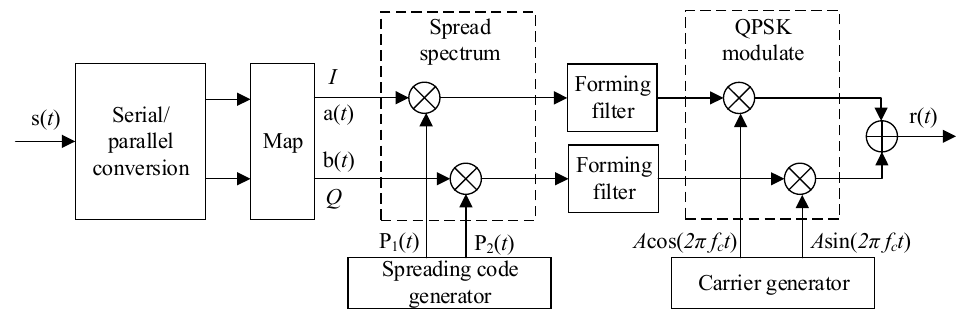
Figure 1. QPSK-DSSS signal model diagram.